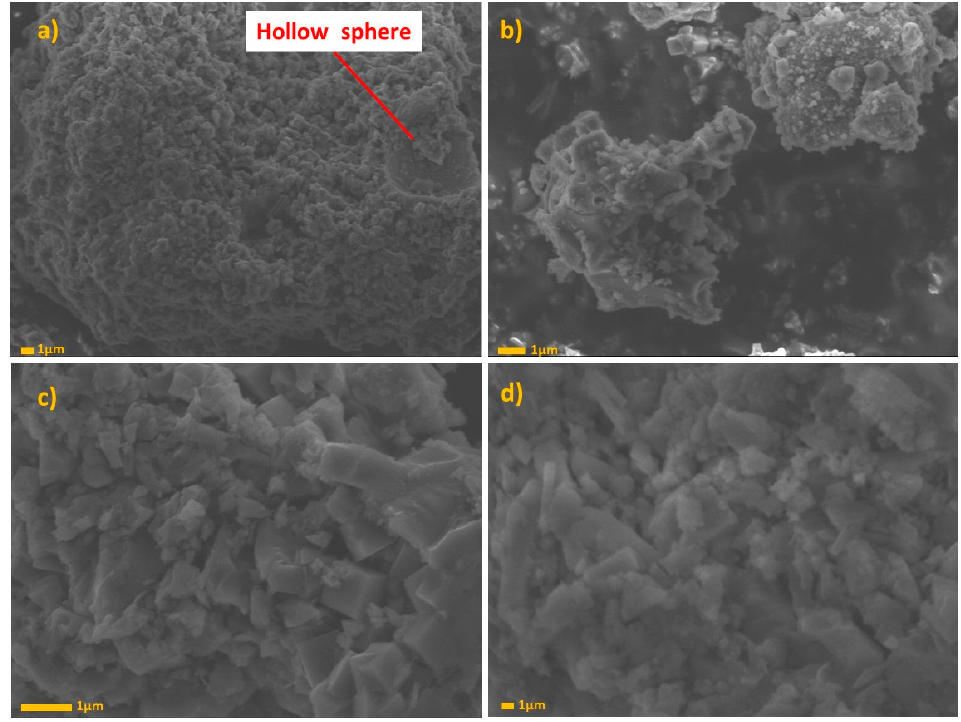
× ( b ) 7000 × , ( c ) 13,000 × , and ( d ) 30,000 × Figure 8. GA SEM images at ( a ) 3000× ( b ) 7000×, ( c ) 13,000×, and ( d ) 30,000×. Figure 8. GA SEM images at ( a ) 3000